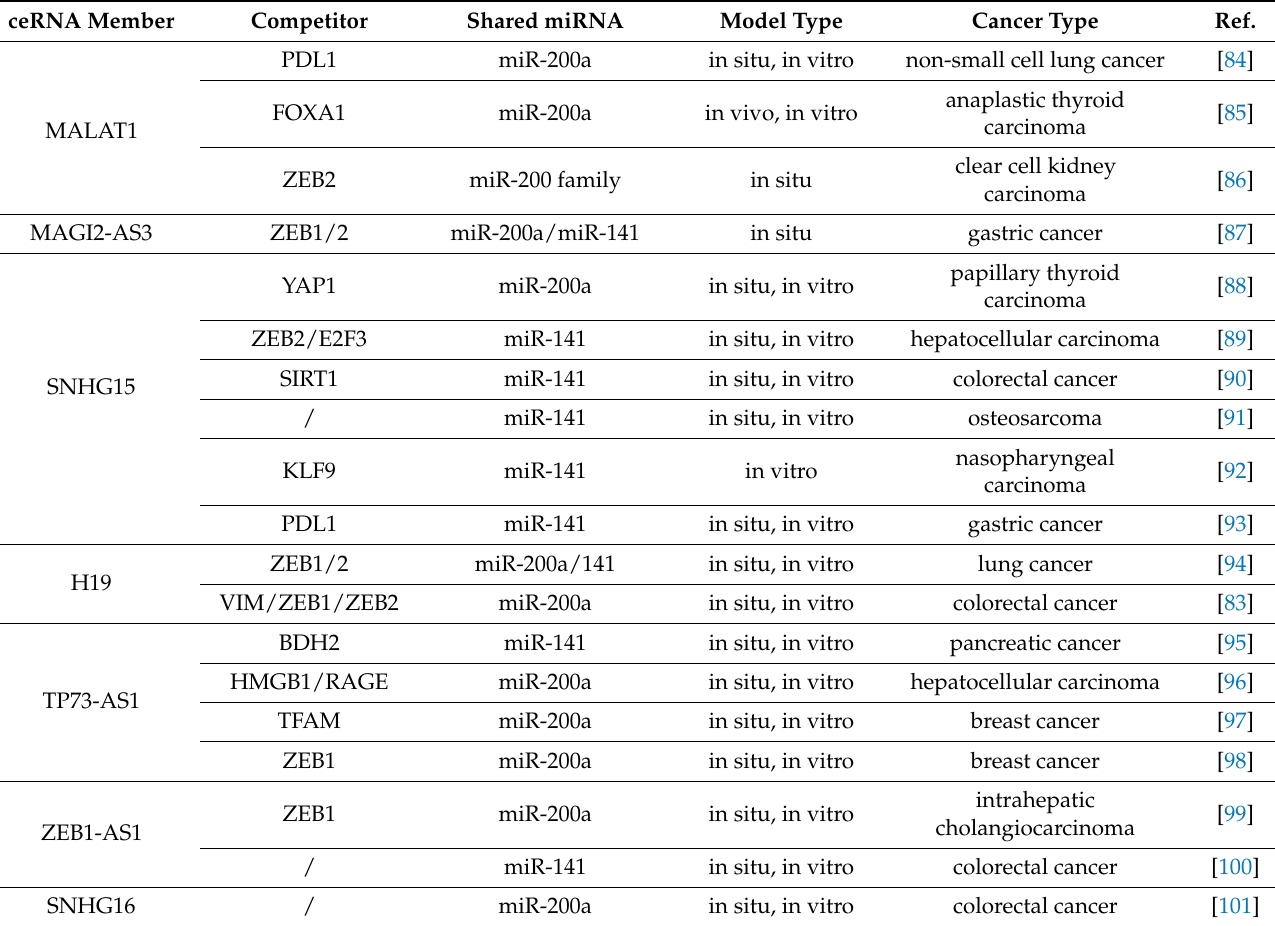
Table 1. Members of lncRNA-miRNA-mRNA ceRNA network type for miRNAs in subgroup I. ceRNA Member Shared miRNA Model Type Cancer Type